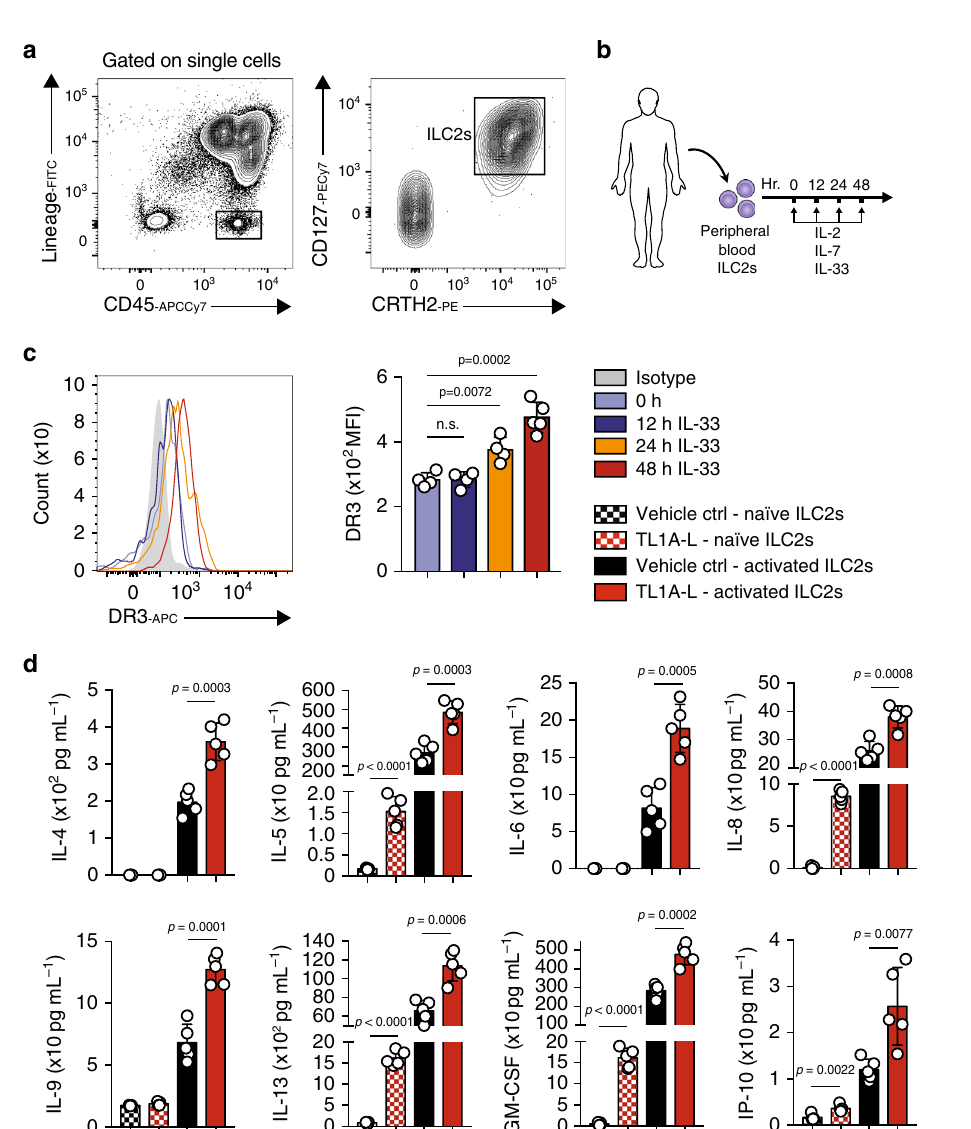
Fig. 7 Human ILC2s express DR3, and this expression is inducible by IL-33. a The gating strategy of Lin - CD45 + CD127 + CRTH2 + human ILC2 cells. b Human peripheral-blood ILC2s were freshly sorted and cultured with 10 ng/mL of recombinant human (rh) IL-2 and rhIL-7 in presence or absence of rhIL-33 (10 ng/mL) for 12, 24, and 48 h. Freshly isolated ILC2 at 0 h and ex vivo activated ILC2s were analyzed by fl ow cytometry as indicated in the scheme, and ( c ) the kinetics of DR3 induction by IL-33 is shown. d The levels of IL-5, IL-6, IL-8, IL-9, IL-13, and GM-CSF in the culture supernatants were measured by Luminex after 48 h of stimulation. Data representative of fi ve individual blood donors, n = 5. Error bars are the mean ± SD. Statistical analysis, one-way ANOVA ( c ) or two-tailed student ’ s t -test ( d ); n.s.: p -value of <0.05 was considered as non-signi fi cant. Human image provided with permission from Servier Medical